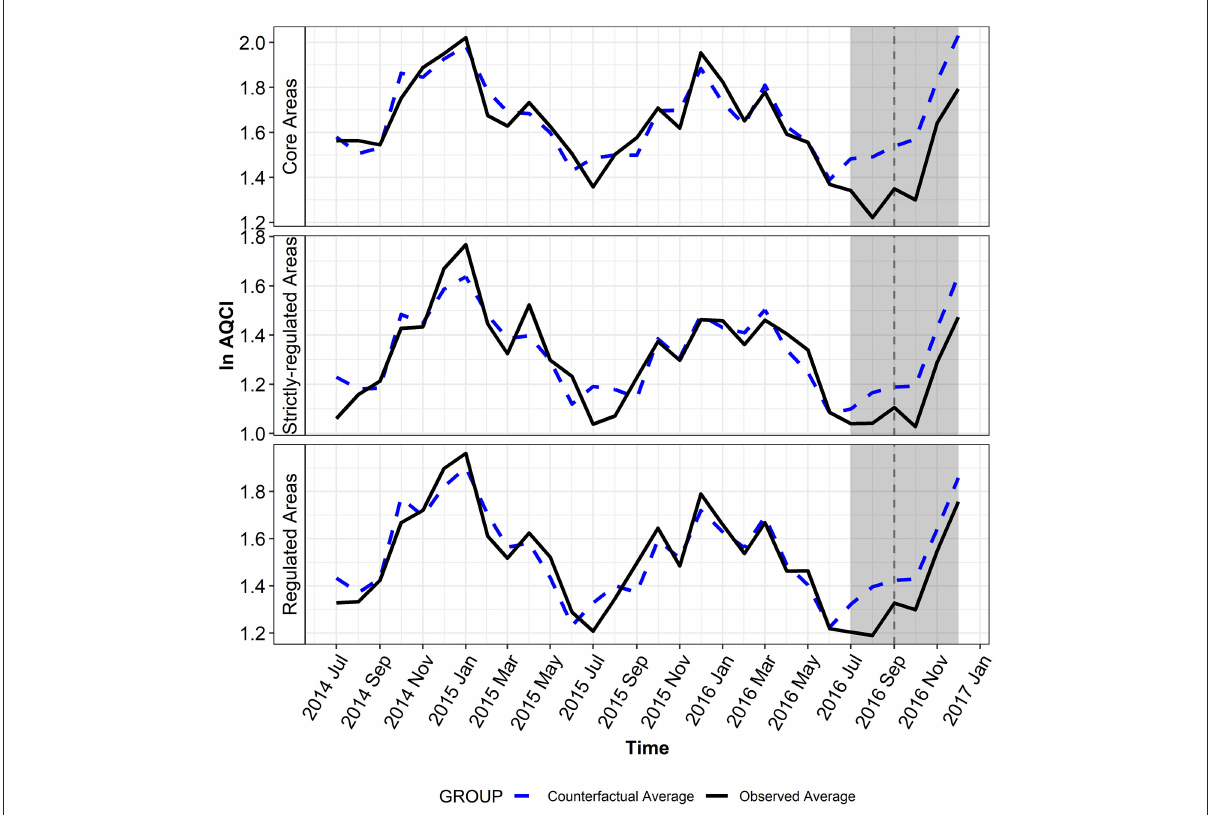
FIGURE3 The observed and counterfactual monthly average of ln AQCI. The treatment period is shaded in gray and the vertical dashed line presents the time of the